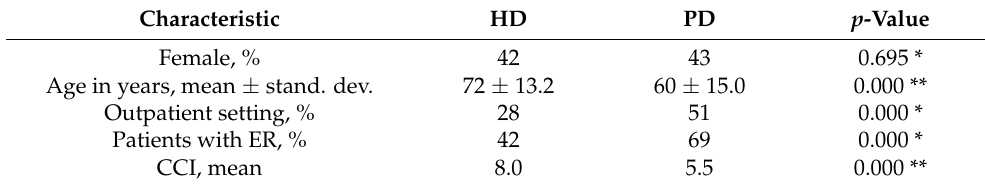
Table 2. Characteristics of patients with ER and